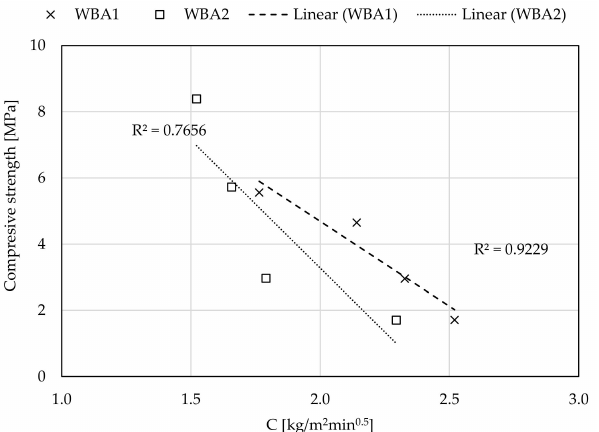
Figure 12. Correlation between the compressive strength and the capillary absorption coefficients. Visual Appearance of the Specimens